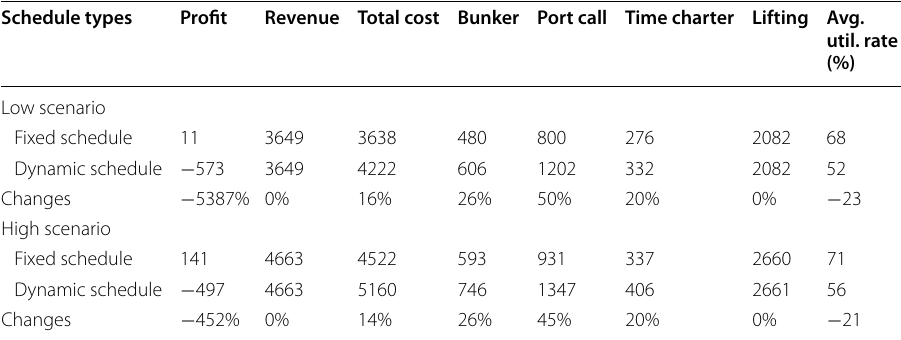
Table 10 Results of LSNDP under fixed schedule and dynamic schedule in the low and high demand scenarios (in thousand